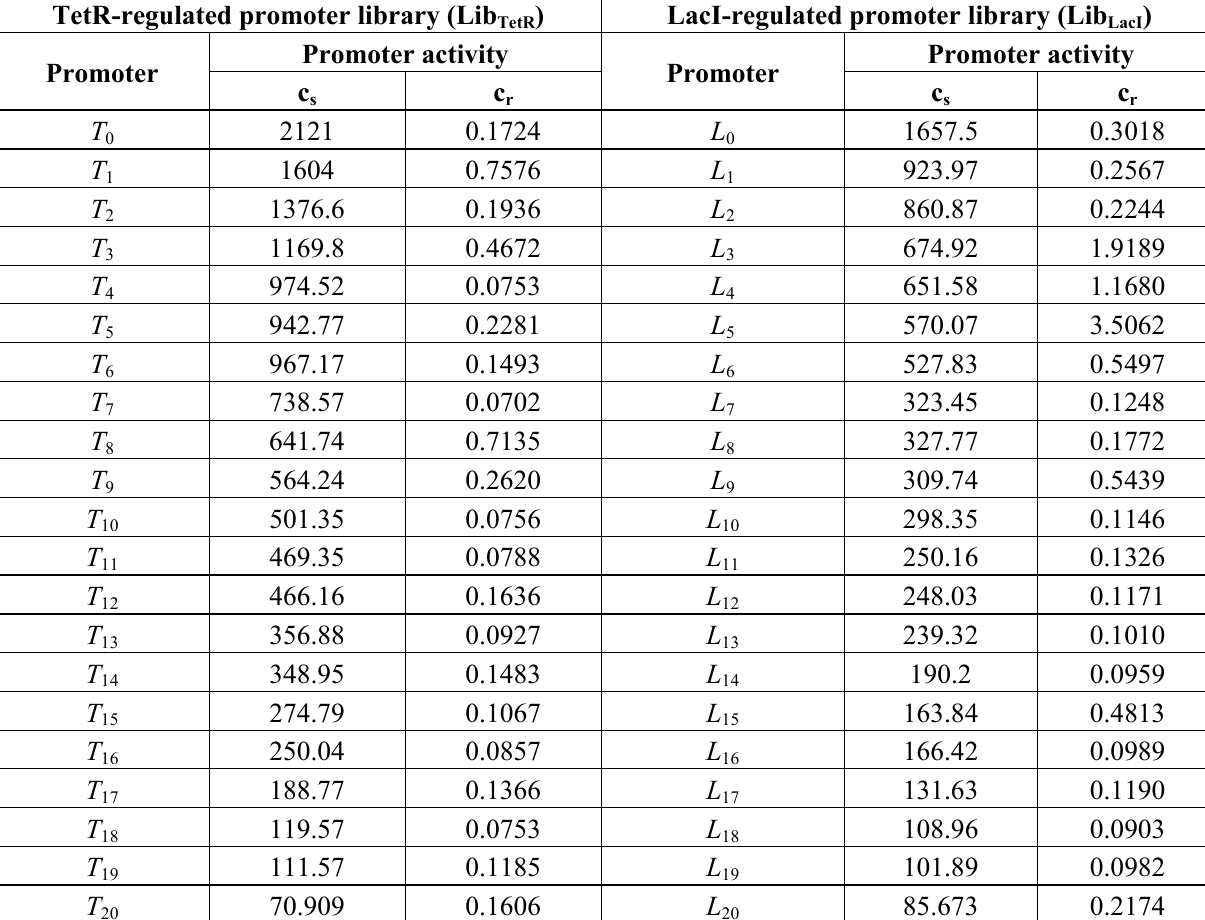
Table 2. Redefined TetR- and LacI-regulated promoter libraries. The redefined TetR- and LacI-regulated promoter libraries ( i.e. , Lib and L , k = 0,…,20) with their corresponding activities of c T k k libraries of experimental data.